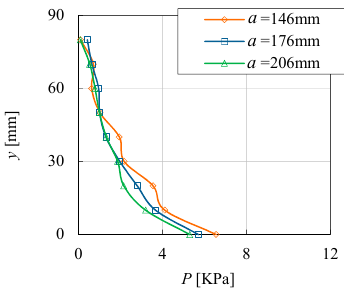
J. Mar. Sci. Eng. 2020 , 8 , x FOR PEER REVIEW Figure 9. Horizontal displacement at the top of structure under different water–structure Figure 9. Horizontal displacement at the top of structure under di ff erent water–structure displacement. displacement.